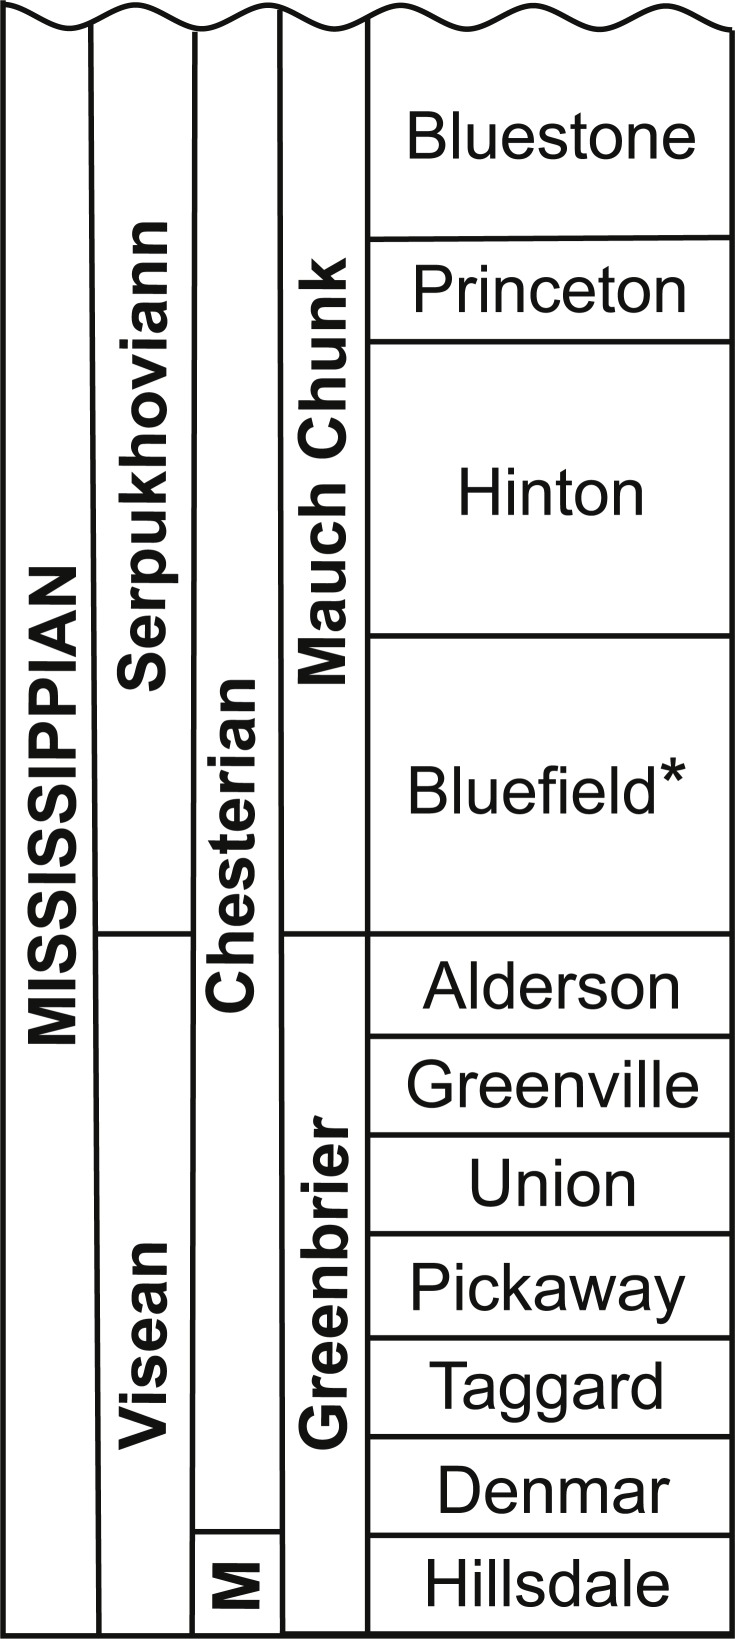
Stratigraphic column detailing the Mauch Chunk Group and the Bluefield Formation of West Virginia.Modified from Powell (2008, fig. 1A). Abbreviation: M, Meramecian. The Bluefield Formation is highlighted with an asterisk.